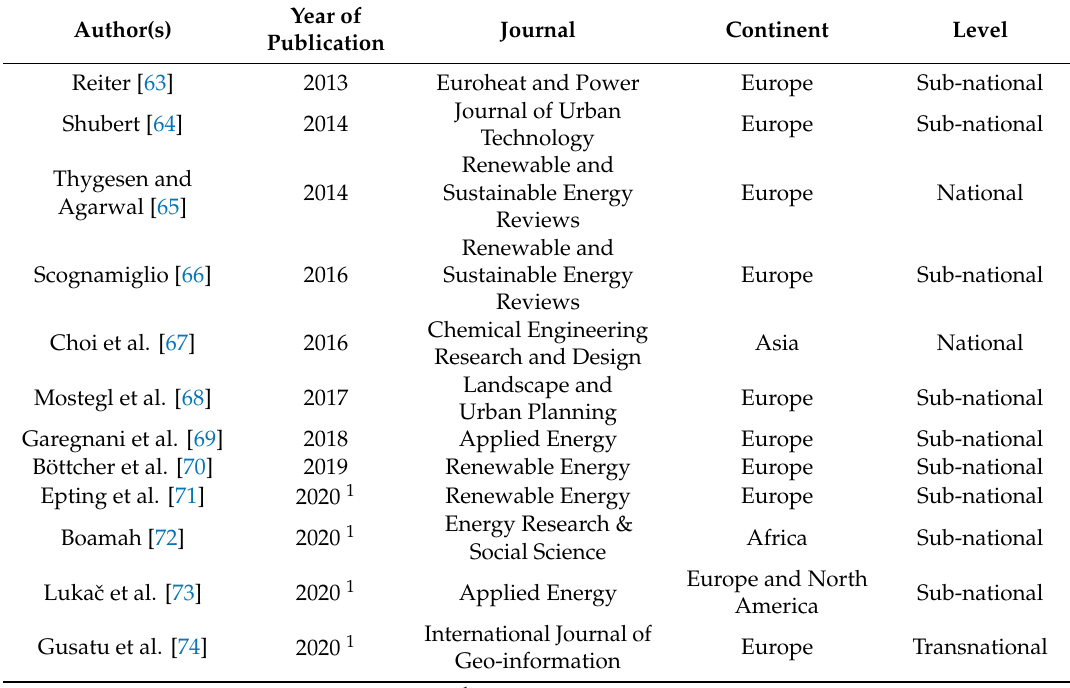
Table 1. Articles selected that include the spatial energy planning (SEP) concept, with their corresponding reference, year and journal of publication, and continent and level of